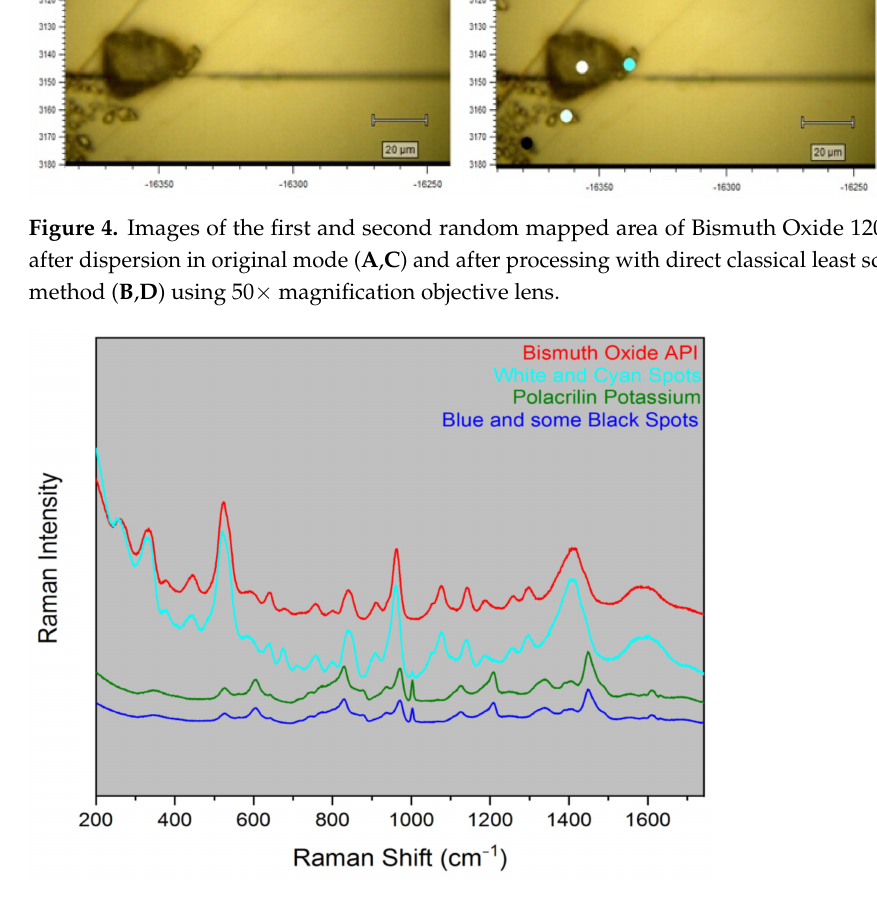
Figure 5. Typical Raman spectra of the particles marked with white and cyan spots (cyan line), blue spots (blue line), and black spots of Figure 4 (black line), colloidal bismuth tripotassium dicitrate (red line), polacrilin potassium (green line), and DMSO (grey